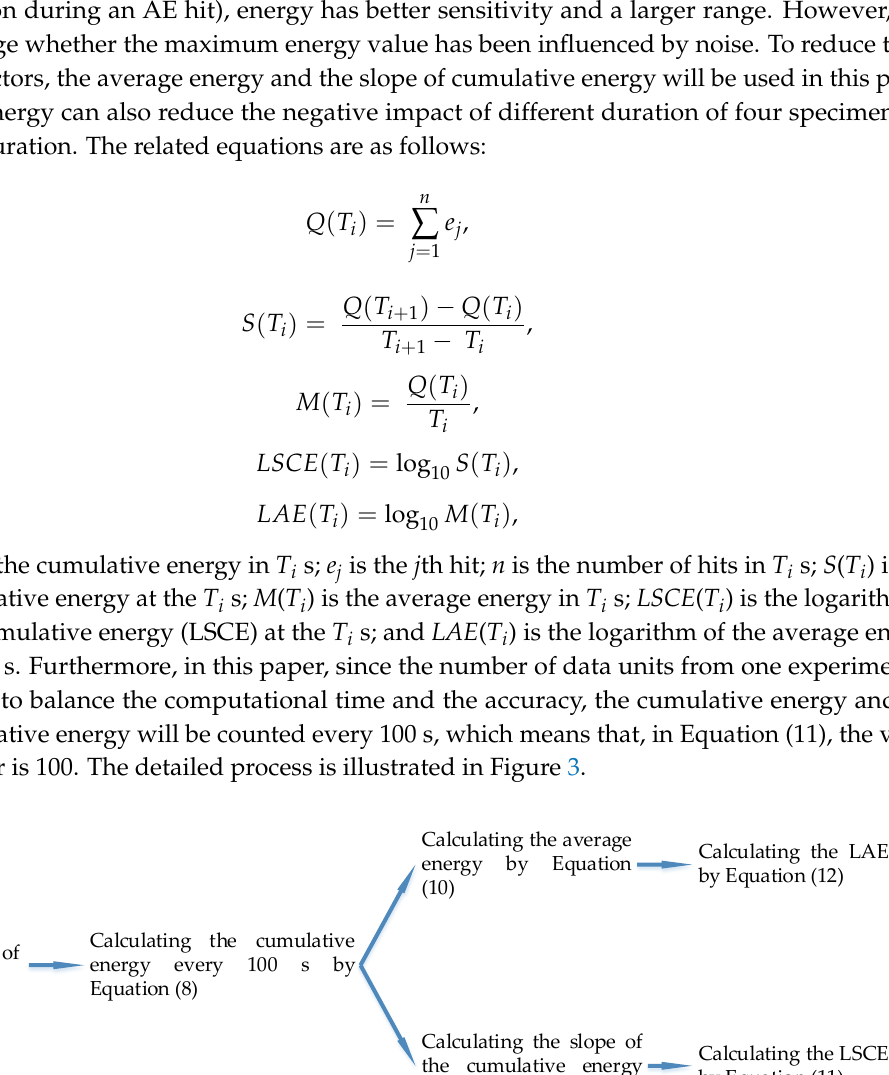
Figure 2. Measurement equipment: ( a ) VHX-600E digital microscope; ( b ) PGI 840 roughmeter.